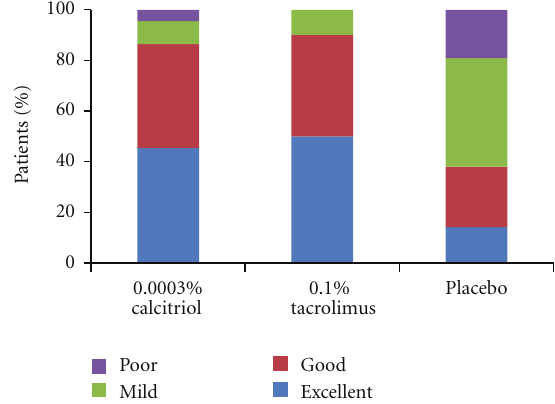
Figure 2: Physician’s assessment of response at PA target lesions at the end of treatment (week 8). Calcitriol and tacrolimus e ffi cacy was rated equally for good and excellent response ( P = 0 . 6, and P = 0 . 8, χ 2 test). Placebo response was significantly lower compared to both drugs in the former categories ( P < 0 . 001, χ 2